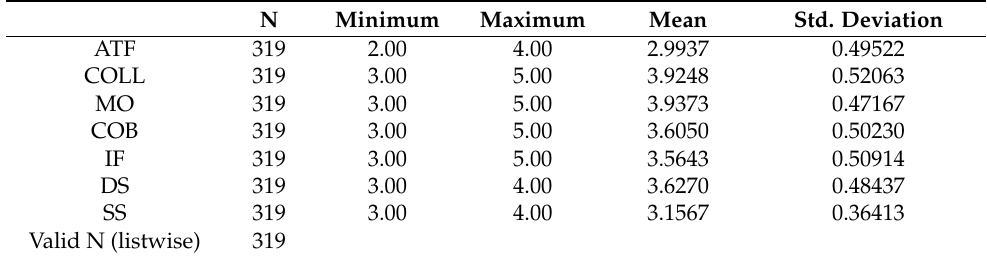
Table 3. Descriptive